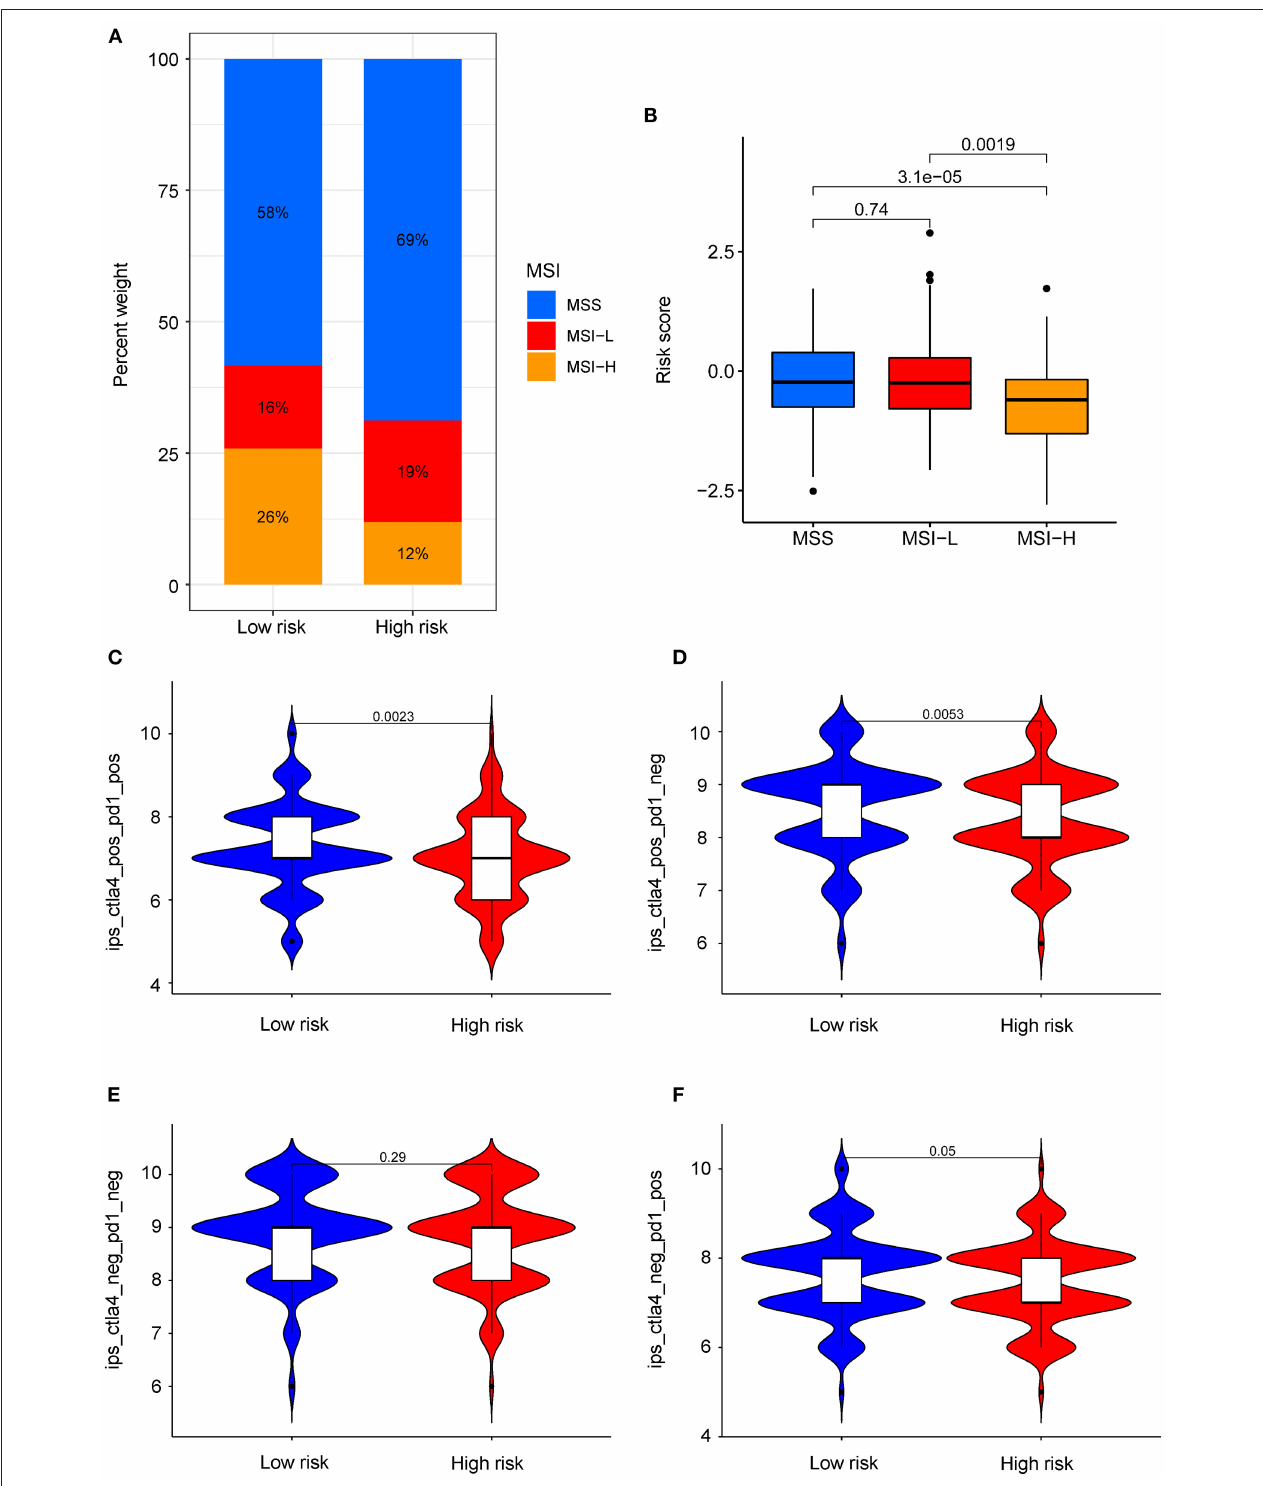
FIGURE 7 | Role of risk score in predicting MSI and immunotherapy benefits. (A) The proportion of different MSI levels in the subgroups with high and low risk score. (B) Differences in risk score among groups with different MSI levels. (C–F) Sensitivity of patients with high and low risk score subgroups to four treatments. (C) PD-1 inhibitor in combination with CTLA-4 inhibitor. (D) CTLA-4 inhibitor alone. (E) Without immune checkpoint inhibitors. (F) PD-1 inhibitor alone.